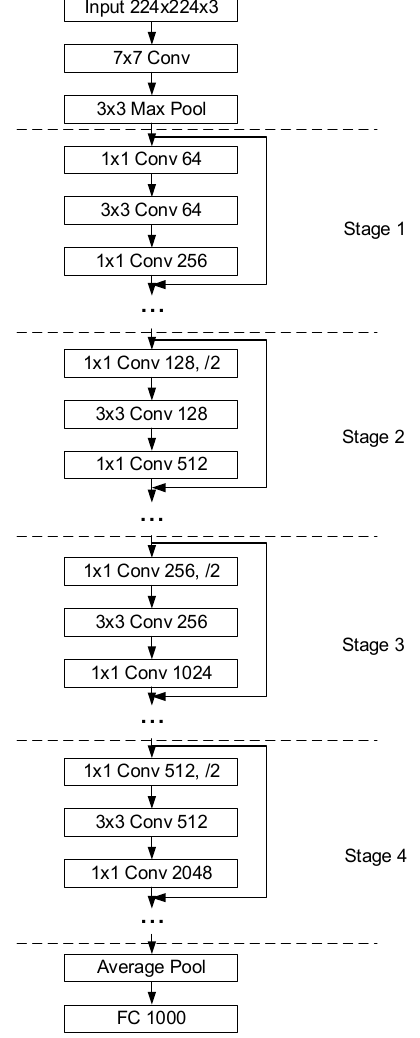
Figure 3. Architecture of ResNet50.